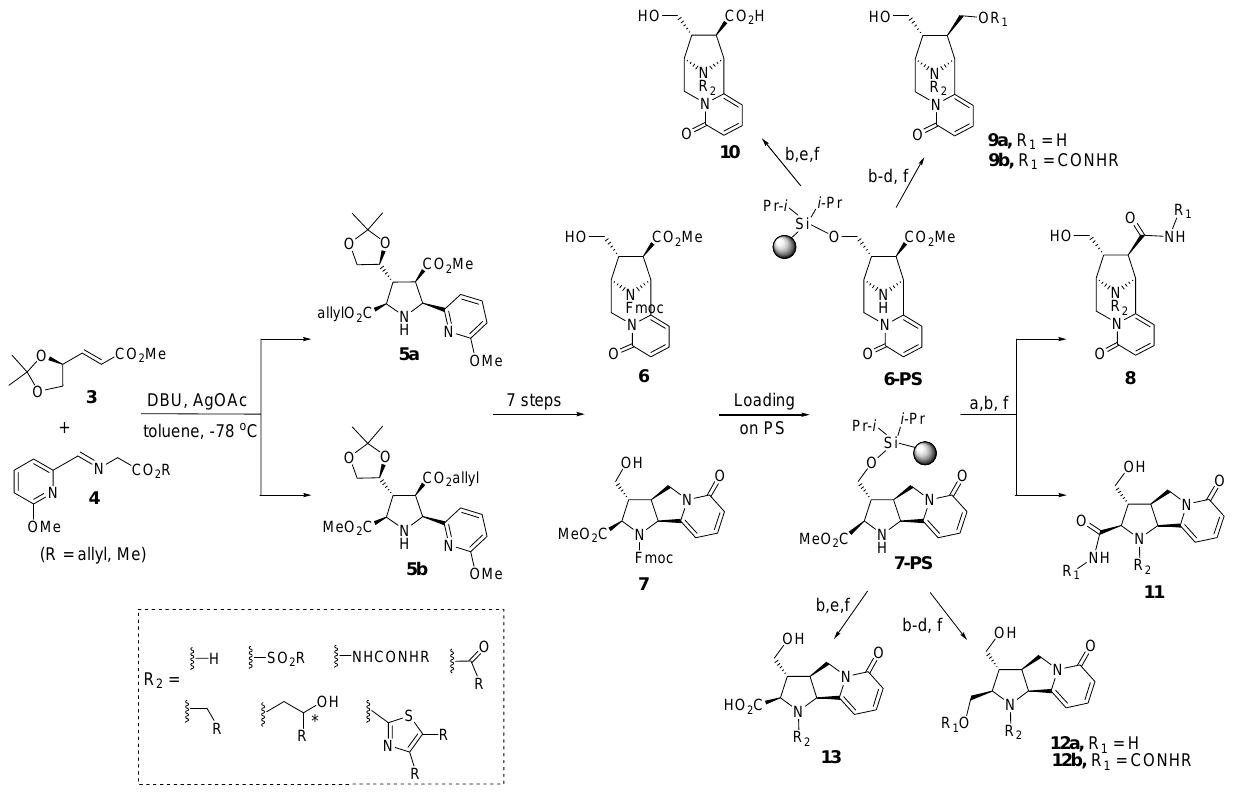
Figure 4. Discovery of Bcl-2 inhibitors based on DOS of pyridone core